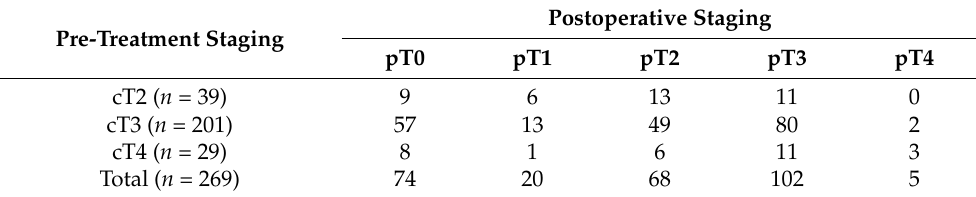
Table 6. Pre-treatment T stage compared with pathologic T stage ( n = 269).